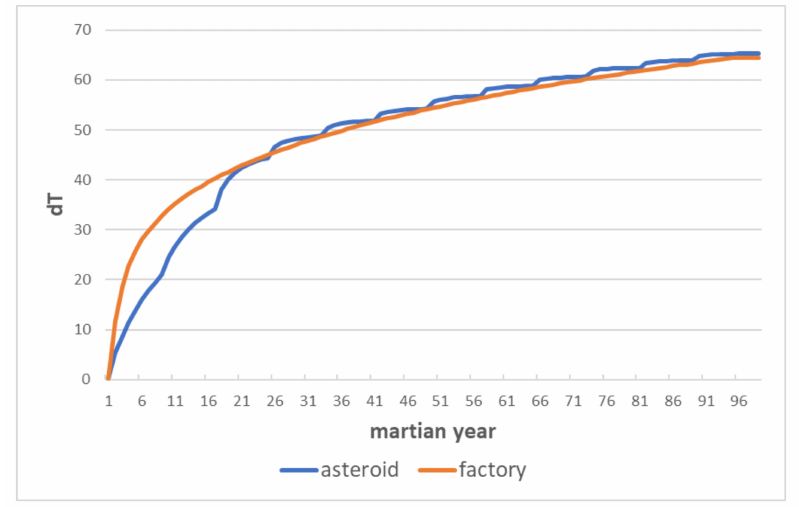
Figure 21. Average temperature rise on Mars over 100 simulation years after the event.